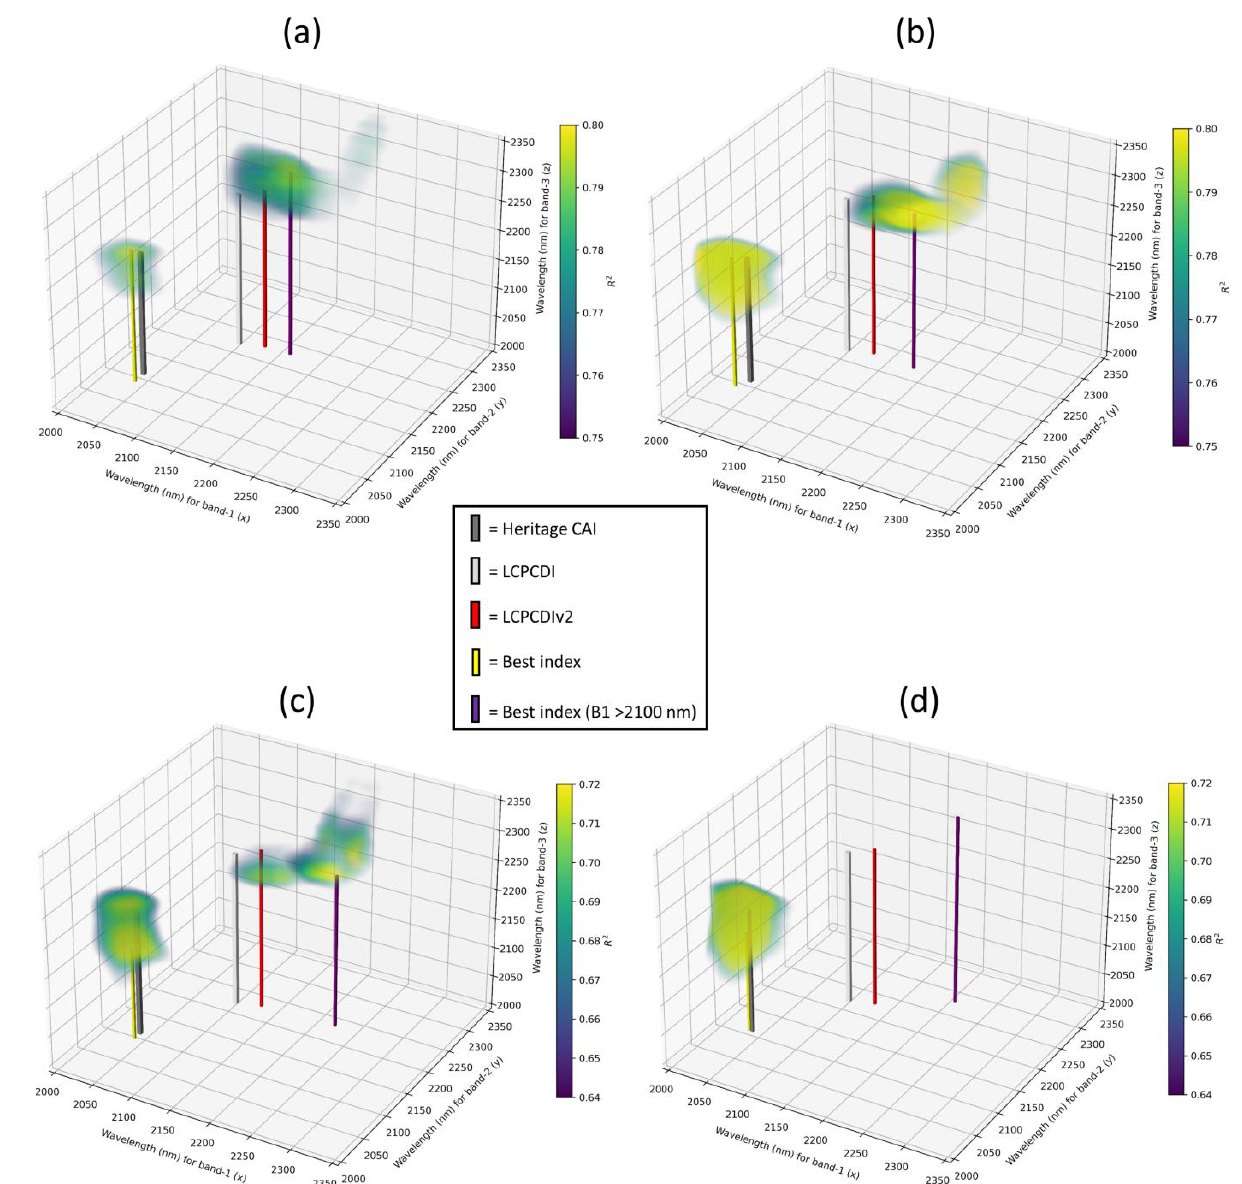
Figure 8. Three-band wavelength shift analysis f R estimation results with the 1 nm interval dataset. Note that in all cases the maximum correlation cluster (yellow bar) is again close to CAI (dark gray bar). While LCPCDIv2 performs well in panels a–c, the best index with the band 1 (B1) > 2100 nm constraint generally shifts the best performing band 1 closer to 2180 nm. Panel d with the full-NDVI and gCPRI is the only case where the LCPCDI-type correlation cluster is not visible as R 2 values do not exceed 0.64. Table 4. Three-band wavelength shift analysis for 1 nm interval BARC dataset. The rows with bold text indicate the top-performing indices in f R estimation with and without the band 1 > 2100 nm constraint and the NDVI < 0.3 and full-NDVI datasets. The underlined values indicate top perfor- mance with the band 1 < 2100 nm constraint. Band-1, Band-2, and Band-3 denote the wavelengths with the highest f R estimation performance for both R 2 and RMSE , with the only exception to this